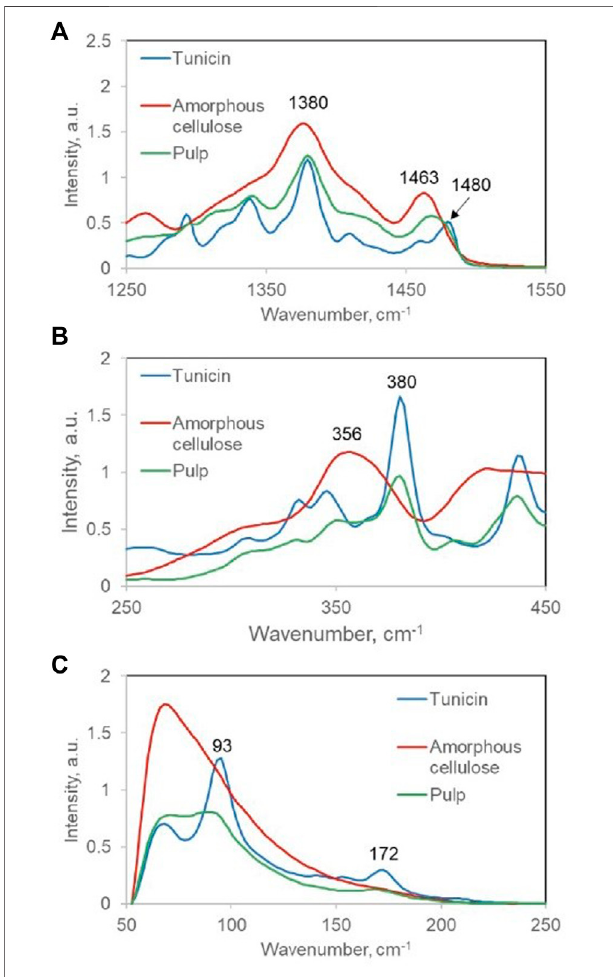
FIGURE1| Ramanspectraoftunicin(veryhighCrI),bleachedhardwood kraft pulp (medium CrI), and completely amorphous cellulose (zero CrI) in the regions on which the three Raman methods are based; (A) 1,481 cm − 1 , (B) 380 cm − 1 , and (C) 93 cm − 1 .